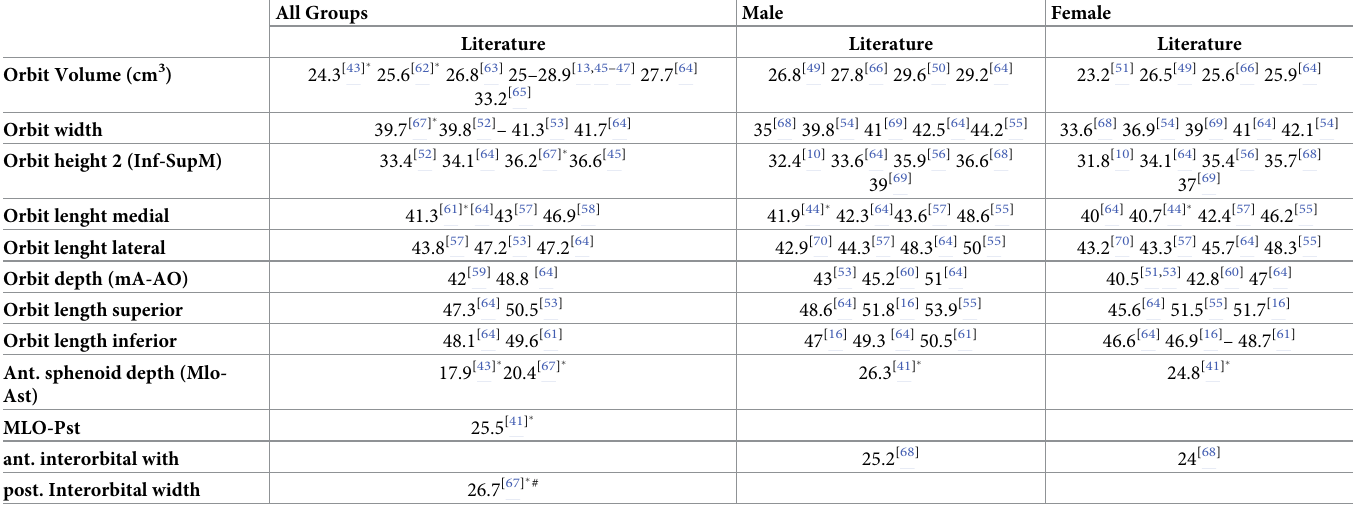
Table 7. Results for distances in derived from previous studies. Mean Orbit Volume is given in ml, Mean Orbit Surface in cm 2 , all further parameters are in mm. Stud- ies on non-Caucasian groups are marked “ � ”. All Groups